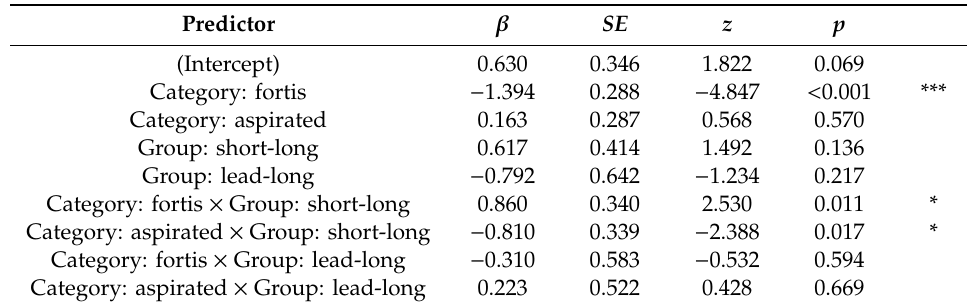
Table 6. Fixed-e ff ect coe ffi cients in the final model of posttest stop identification [ N = 1539, log likelihood = − 885.7]. Significance codes: * p < 0.05, *** p < 0.001.